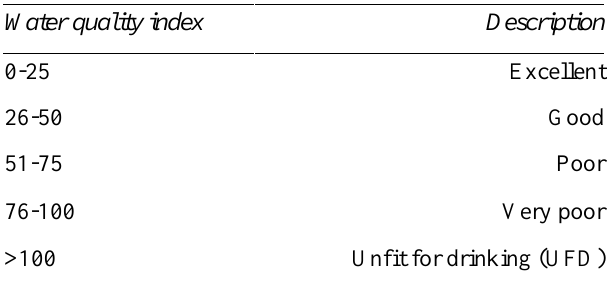
Results and Discussion